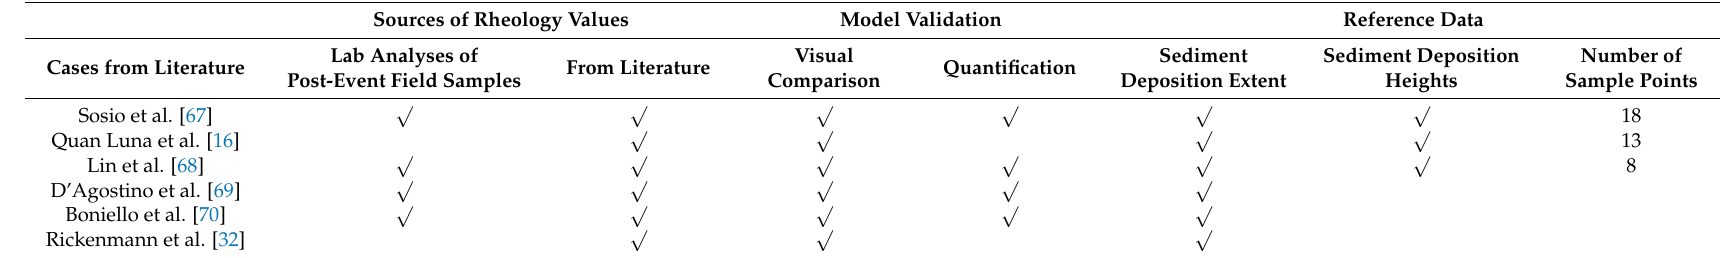
Table 1. Summary of published literature that assessed FLO-2D model